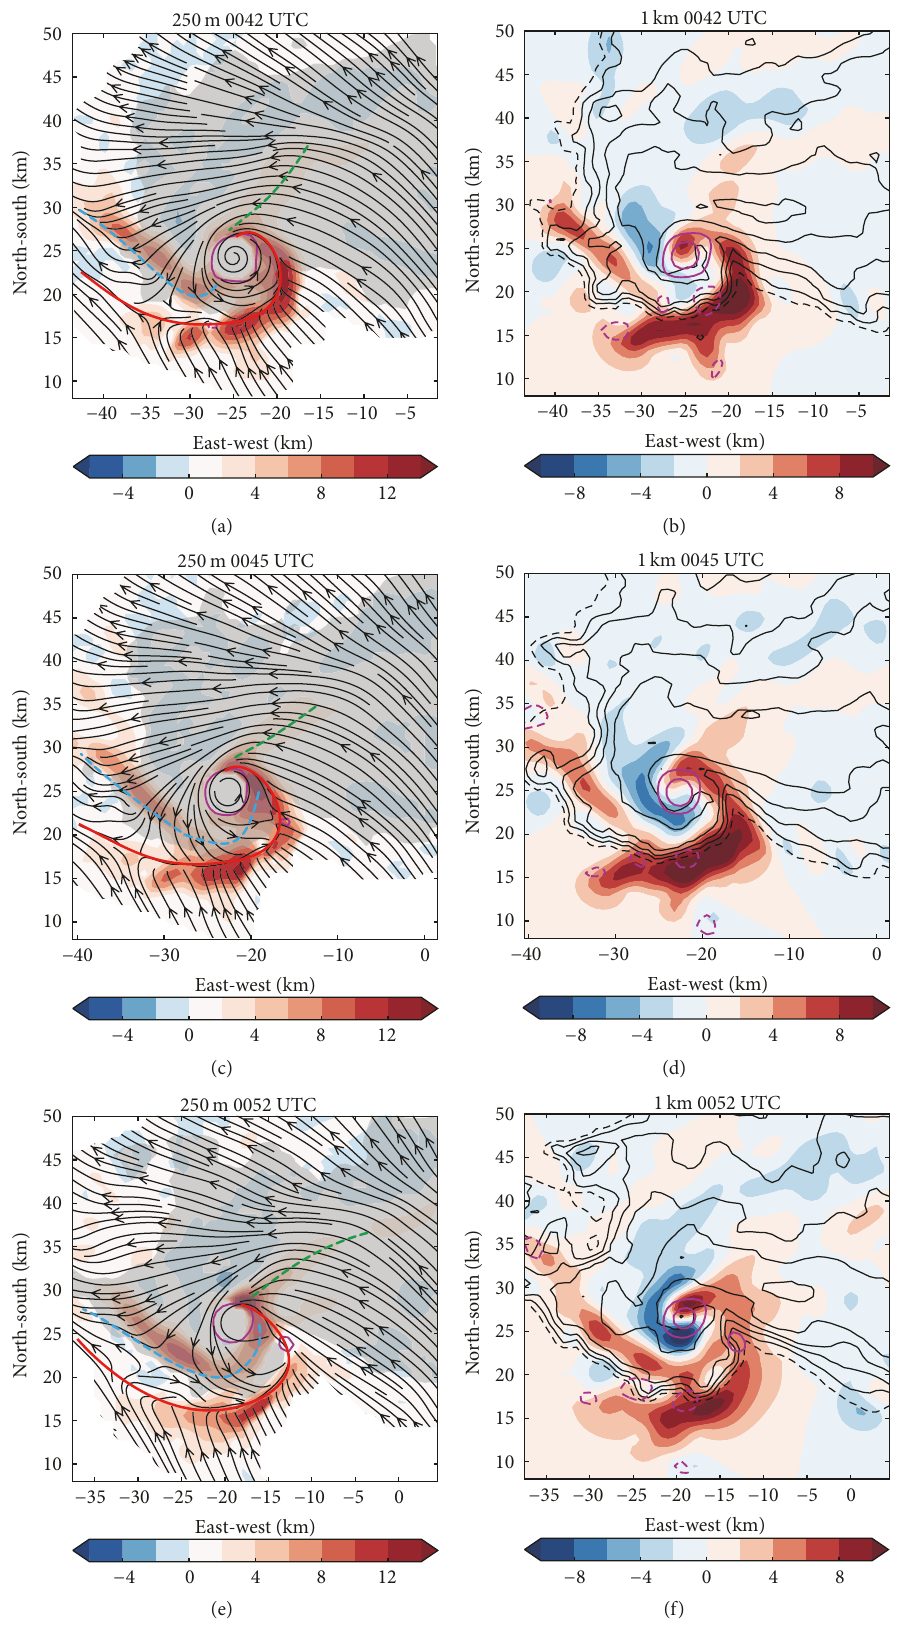
Figure 7: Same as Figure 3, except for during the occlusion